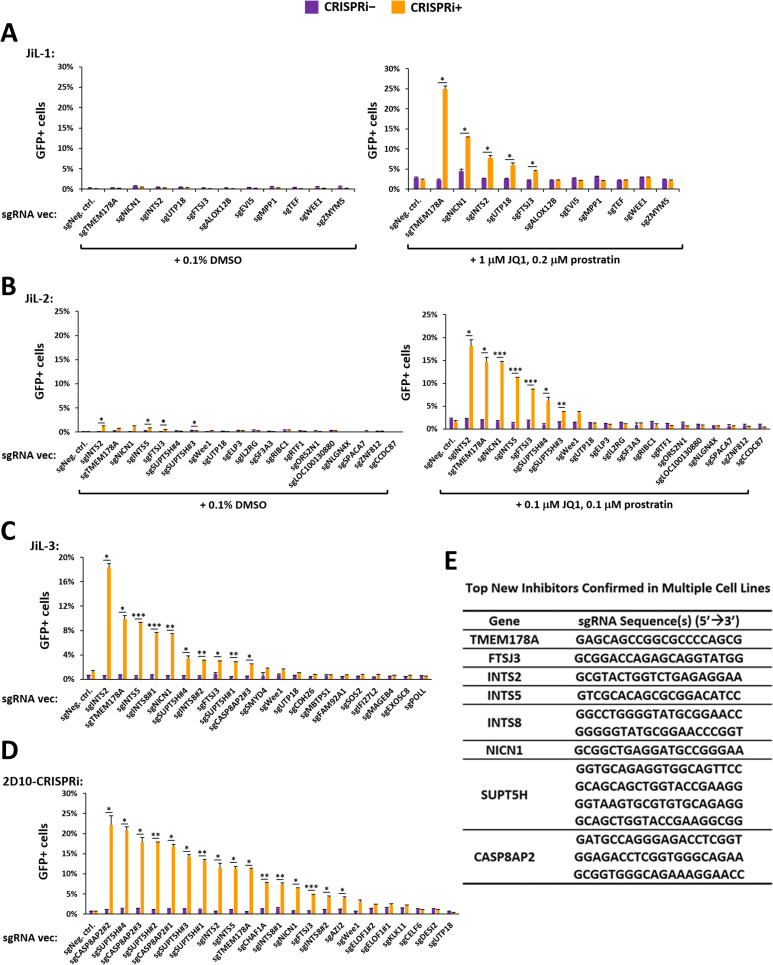
Individual Confirmation of Host Latency Promoting Factors that Decrease Inducibility of Latent HIV-1.A., B., C., & D. JiL-1, JiL-2, JiL-3 and 2D10-CRISPRi cells were transduced with the indicated sgRNA expression vectors, selected by puromycin, and then treated with either 0.1% DMSO (CRISPRi−) or 1 μg/ml Dox (CRISPRi+) for 3 days. Aliquots of JiL-1 and JiL-2 cells were also treated with the indicated concentrations of JQ1 and prostratin for 20 hours to examine synergy between the sgRNAs and the LRAs. The cells were then examined by flow cytometry to determine GFP+%. Error bars represent mean +/− SD from two experimental replicates. Asterisks denote levels of statistical significance calculated by two-tailed Student’s t-test (*: p<0.05, **: p<0.01, and ***: p<0.001). E. A list of the new HIV latency promoting gene products identified in this study and their corresponding sgRNAs confirmed to be effective in multiple cell lines.